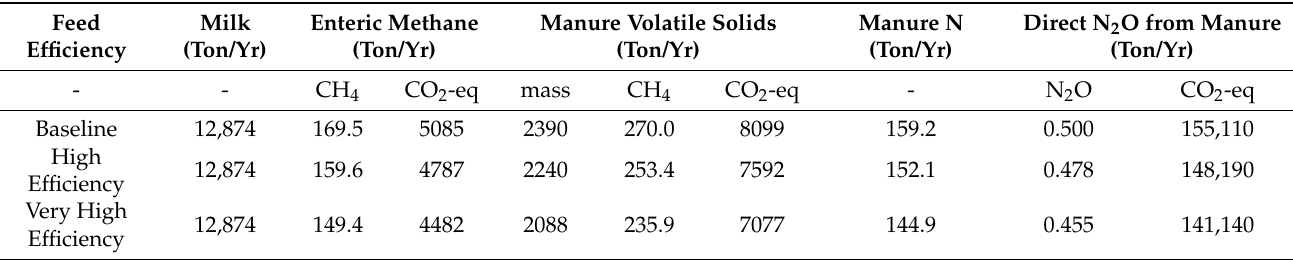
Table 5. Expected total milk production, enteric methane, manure volatile solids, and manure N from a 1000-cow, 365-day RuFaS simulation with 3 levels of feed efficiency: baseline ( ρ = 1), high ( ρ = 0.94), and very high ( ρ =